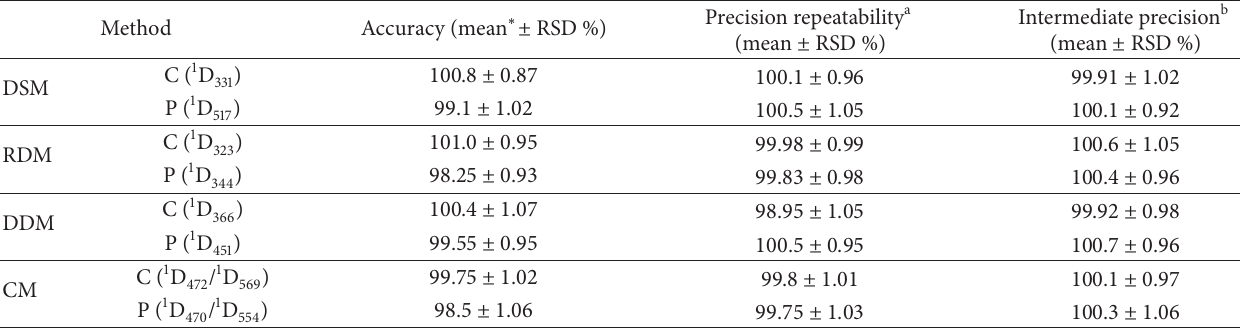
Table 3: Method validation for the simultaneous determination of Carmoisine and Ponceau 4R in laboratory prepared mixtures by the proposed